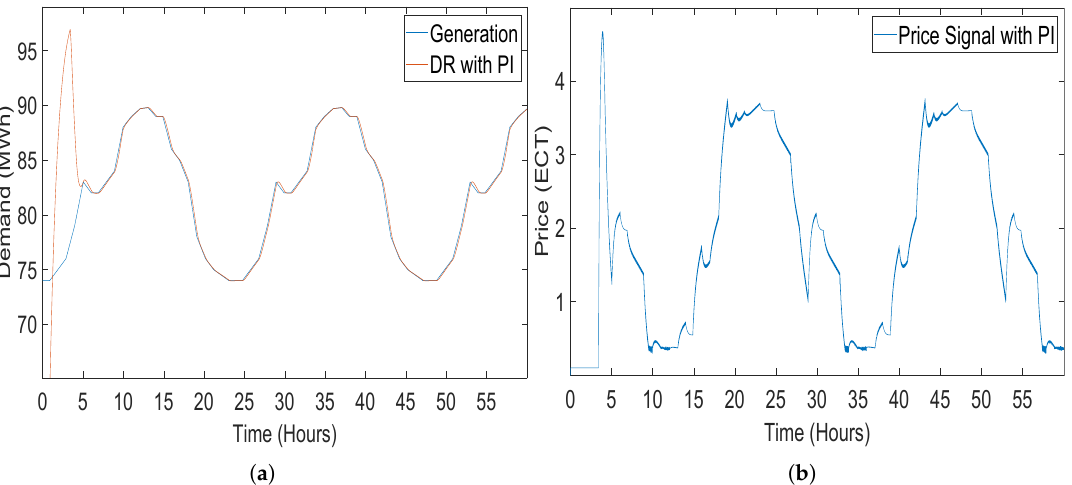
Figure 14. Closed-loop elastic demand control using a proportional integral (PI) controller having coefficient values K p = − 1 and K p = − 2: ( a ) demand response; ( b ) price